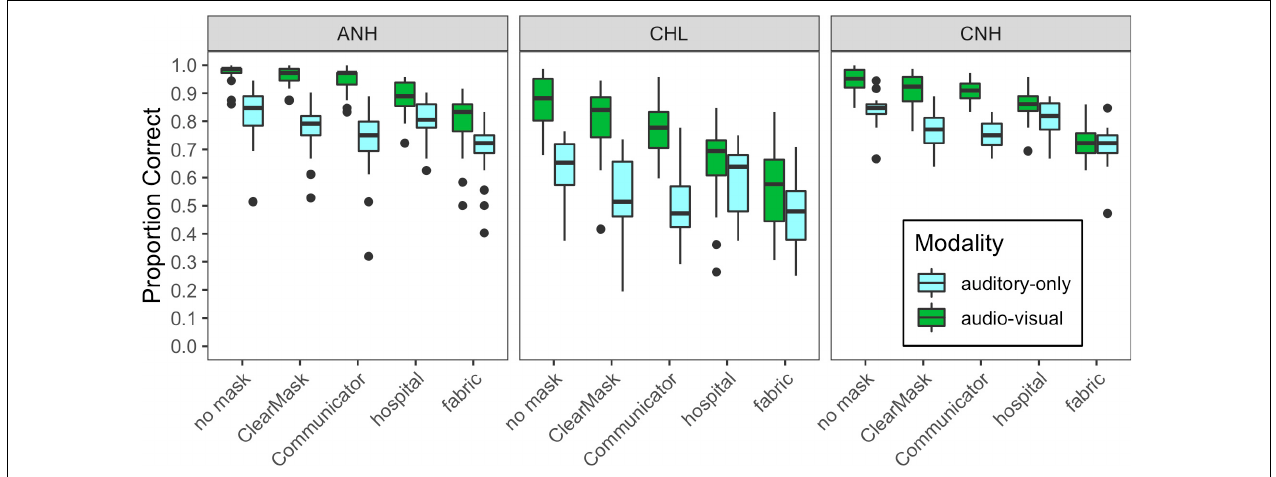
FIGURE 4 | Distribution of scores for each of the auditory-only and audiovisual stimulus conditions, plotted separately for each of the three groups of subjects tested in Experiment 1, as indicated at the top of each panel. Mask type is indicated on the horizontal axis, and cue condition is indicated with box fill, as defined in the legend. Vertical lines indicate the median, boxes span the 25th to 75th percentiles, and vertical lines span the 10th to 90th